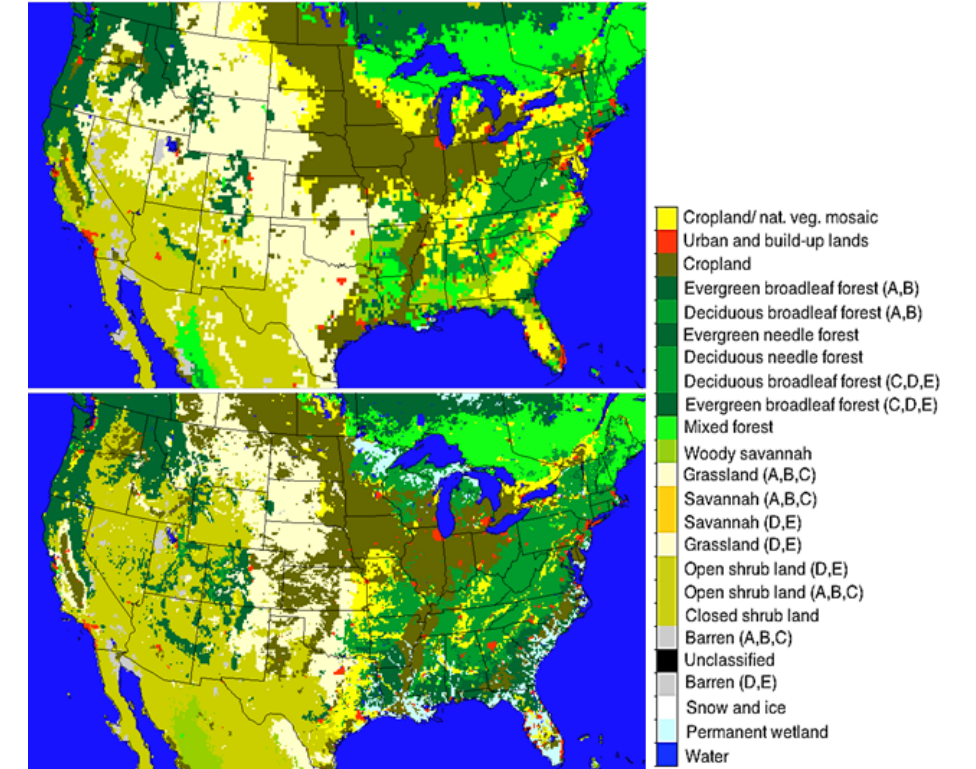
Figure 2. Biomes from GEOS-Chem (0.25 ◦ × 0.25 ◦ ; top) and CMAQ MODIS NLCD40 (12km × 12km; bottom) regrouped to match the classifications for which emission factors are available from Steinkamp and Lawrence (2011). See Tables A1 and A2 (right) for the mappings between classifications. The color-bar legends for classifications are as per NLCD definitions